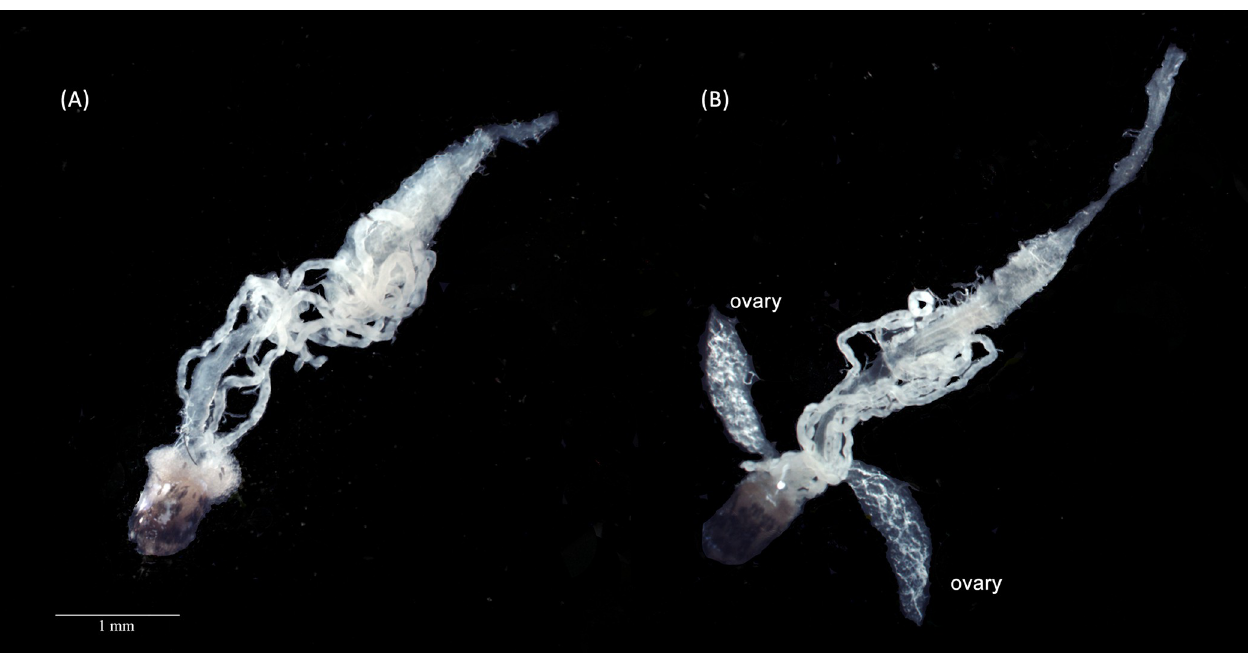
Fig 1. Appearance of internal organs in w AlbB-infected Aedes aegypti mosquitoes. (A) Infertile females lack observable ovaries, while ovaries are present in (B) fertile females (labelled as “ovary”). The background of the photographs was removed for clarity, with the original photographs presented in S3 Fig.